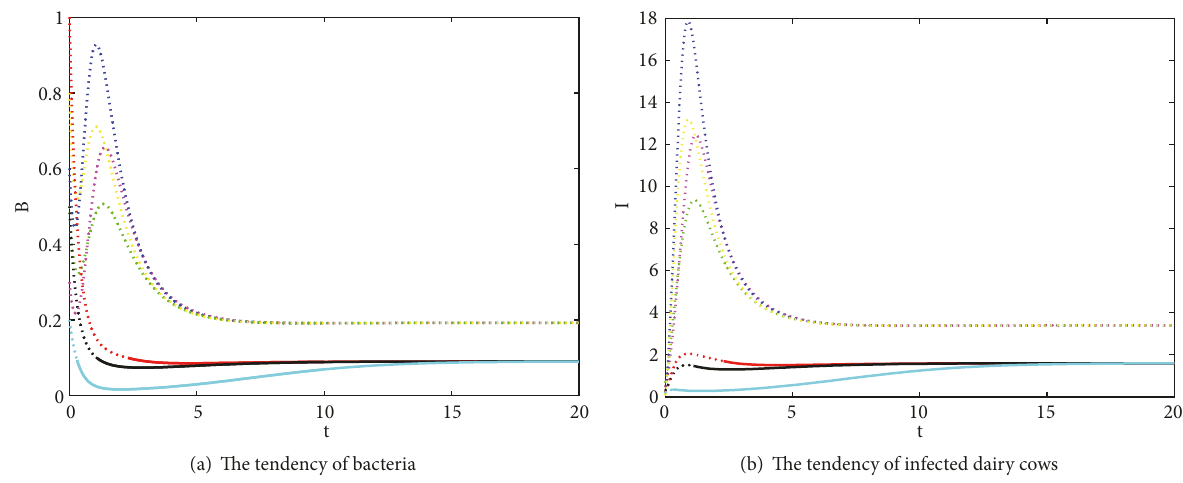
Figure 5: The common values of (a) and (b) used for the parameters are as follows: 𝑤 = 3 , 𝑑 = 2 , 𝑐 = 0.8 , 𝛿 = 4 , 𝑞 = 1 , 𝛽 = 0.2 , 𝑎 = 2 , 𝑚 = 0.1 , 𝑀 = 0.1 , and 𝐴 = 25 . Different colors are representative of different initial values, of which the dot line means that it enters system (6) and the full line means that it goes into system (9) as in Figure